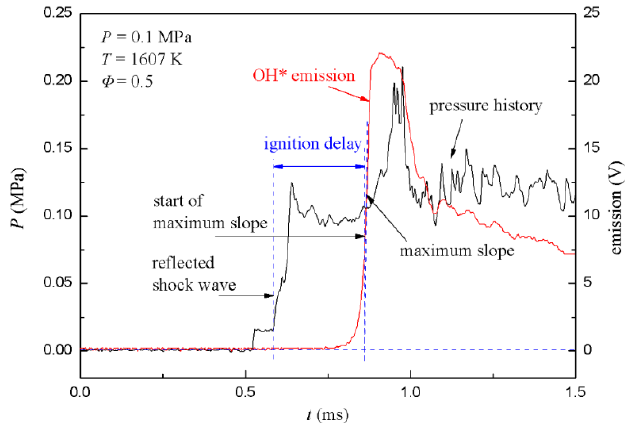
Figure 7. Typical profiles of pressure and OH* emission signals for toluene / 21%O 2 / N 2 . The arrival time of the reflected shock wave at PCB3 was used to initiate ignition, and the start of the maximum slope point of OH* emission was taken as the end of ignition [23]. The ignition delay time was calculated as the time difference between the two times. According to the measured shock velocity (or Mach number) and the initial pressure and temperature of the driven section, the ignition pressure and temperature were obtained by the Gaseq software [24] with frozen chemistry assumption. Thus the ignition delay times were obtained from the aerosol shock tube.